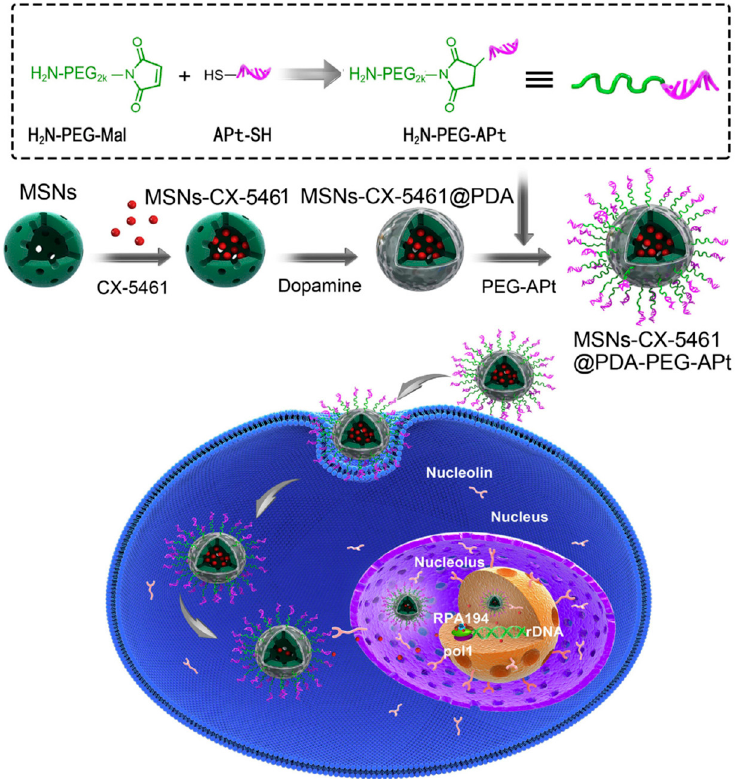
Figure 3. Aptamer-conjugated nanoparticles (NPs). Scheme of CX-5461-loaded mesoporous silica NPs modified with AS-1411 aptamers to increase nucleoli targeting. Reproduced with permission from Reference ref. 34.